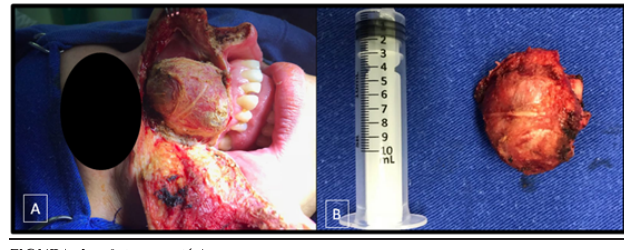
FIGURA 4 – Intraoperatório Incidência intraoperatória da lesão e dissecção cirúrgica ao seu redor por meio do acesso de Weber-Ferguson-Diefenbach (A) e lesão íntegra após excisão cirúrgica (B).